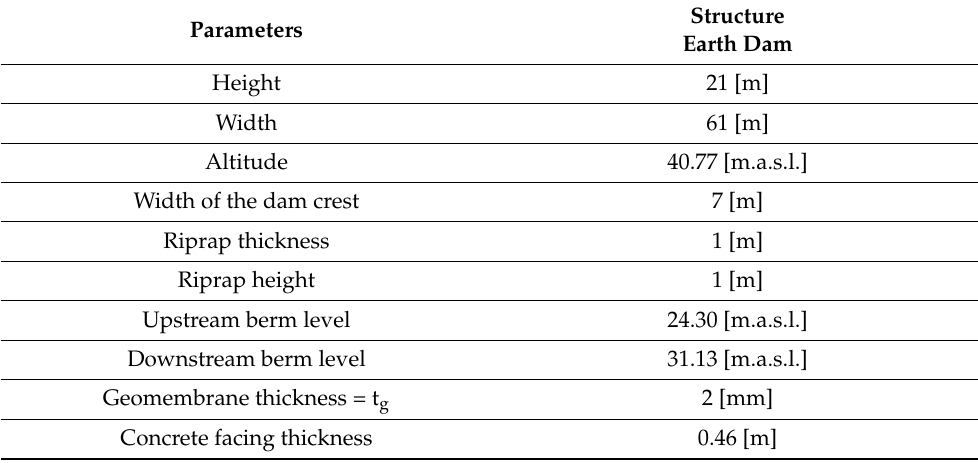
Table 10. Characteristics of the earth dam.